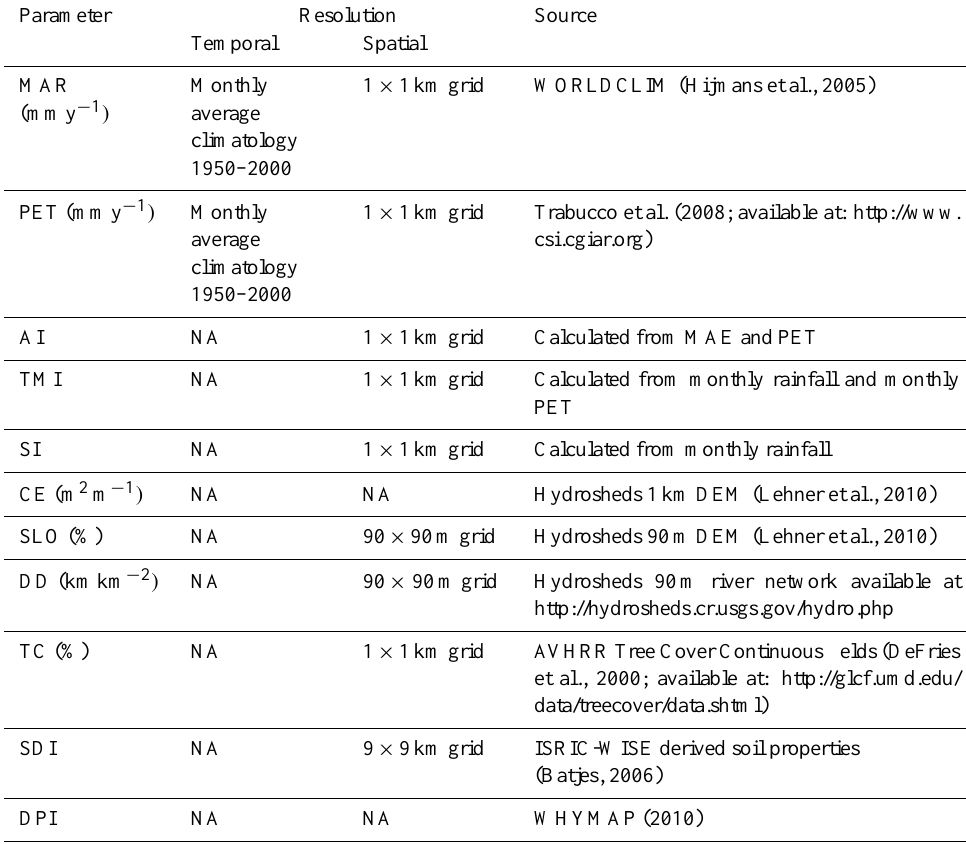
Table 1. Summary of climatic and terrain attributes used in the present